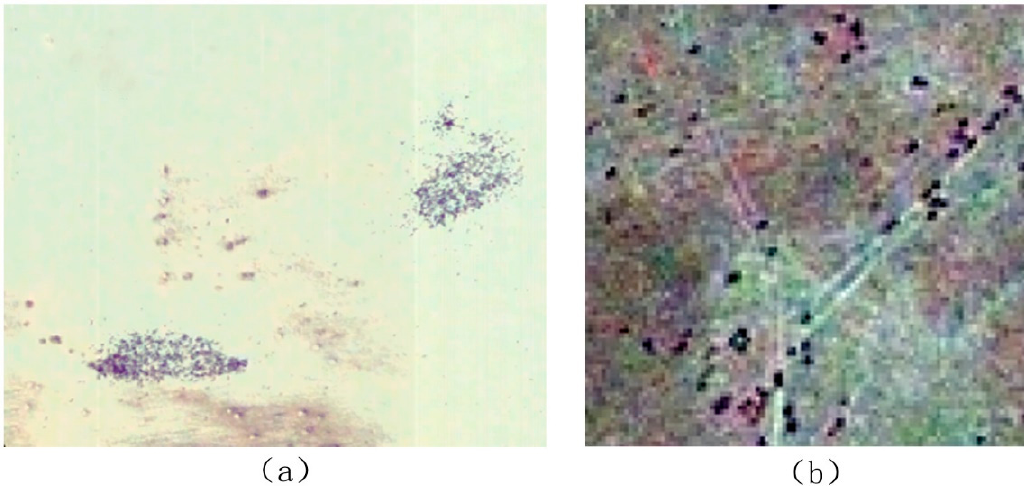
Figure 2. Two VHR satellite images of wild animals. ( a ) Emperor penguins ( Aptenodytes forsteri ) are shown as black / gray pixels, and guano is shown as brown pixels in a pansharpened QuickBird image from Fretwell et al. [67]. ( b ) Migration season of wildebeests ( Connochaetes gnou ) and zebras ( Equus quagga ) in a GeoEye-1 satellite image from Yang et al. [29]. Note: The QuickBird and GeoEye-1 images have resolutions of 0.61 m and 0.5 m (at nadir), respectively, in the corresponding panchromatic bands. The use of these two images was authorized by the DigitalGlobe Foundation. Table 3. Animal species detected using spaceborne imagery.